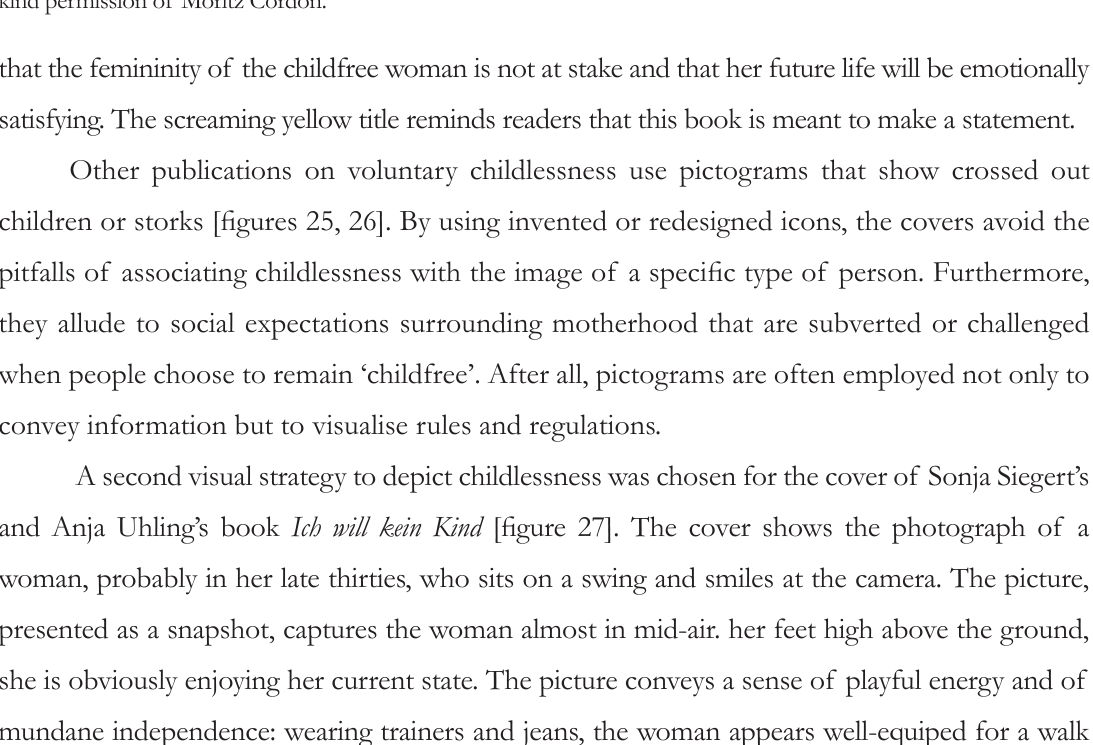
Figure 26. Childfree or: why people without offspring aren’t freeloaders (2011) Used with kind permission of Herbig